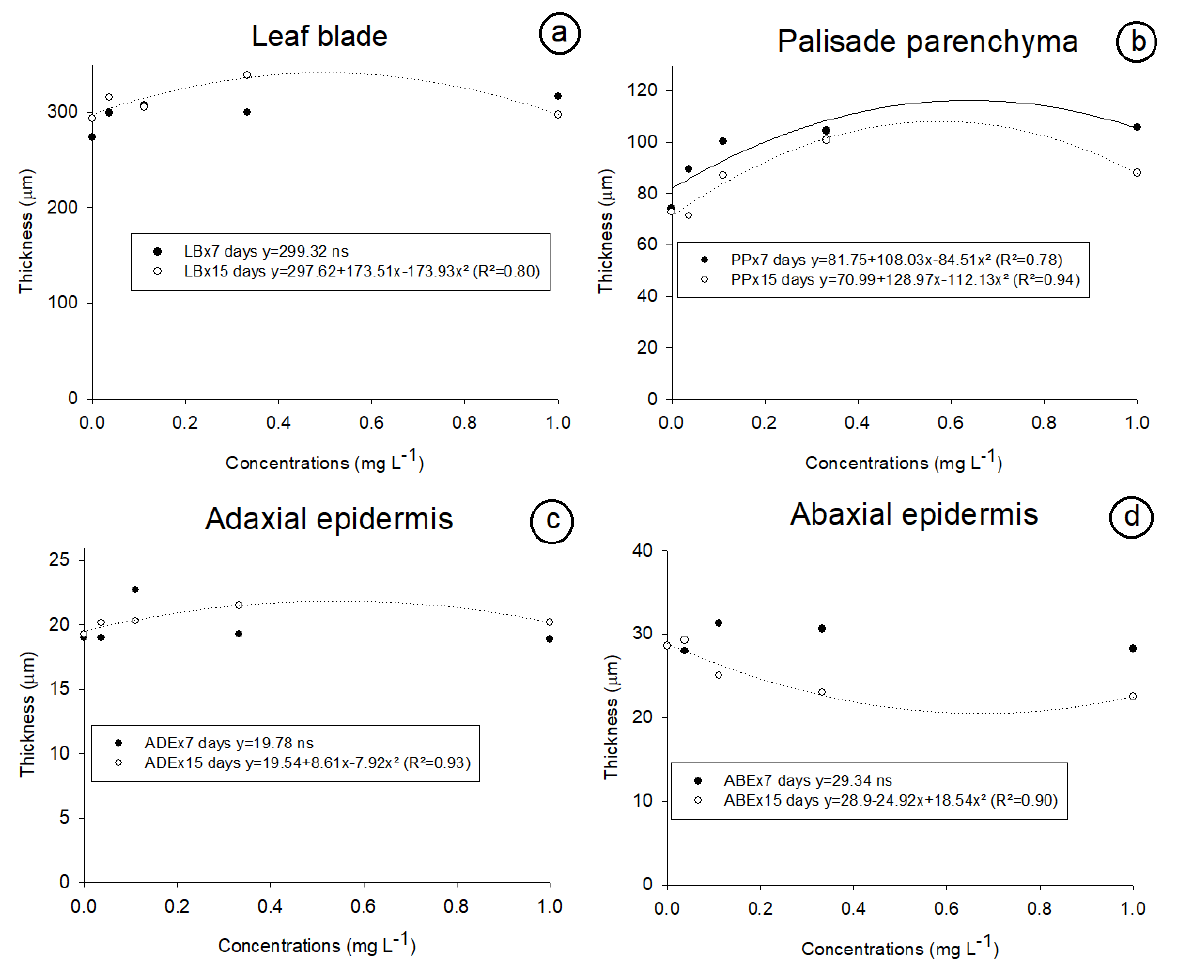
Figure 6. Thickness of leaf tissues of P. stratiotes obtained from cross sections of leaf blades collected at 7 and 15 days after clomazone application. a . Leaf blade thickness; b . Palisade parenchyma thickness; c . Adaxial epidermis thickness; d . Abaxial epidermis